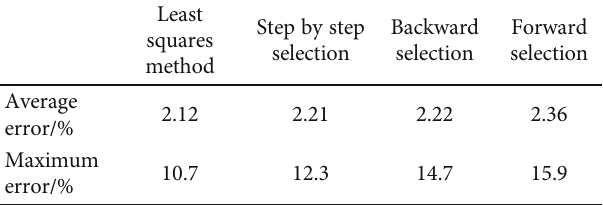
Table 4: Error analysis of the separation e ffi ciency